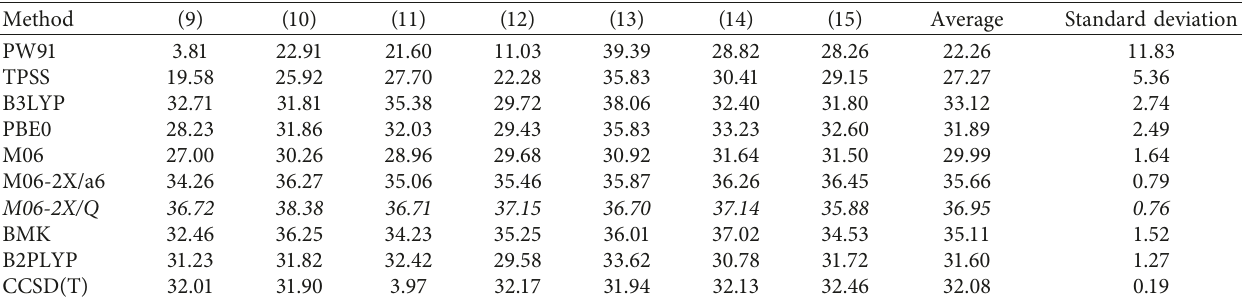
Figure 11: CCSD(T) calculation of the enthalpy of formation of ClClO (in kcal/mol) using different basis sets and reactions. Full lines refer to reactions between closed-shell molecules. Dashed lines are the results for reactions involving radicals. The dotted black line is the average for all the reactions for each basis Table 7: Enthalpies of formation of ClClO (in kcal/mol) obtained from reactions (3) and (9)–(14) using the indicated method and the aug- cc-pV6Z basis set. The average value of those obtained for all the reactions and the standard deviation are shown in the table.